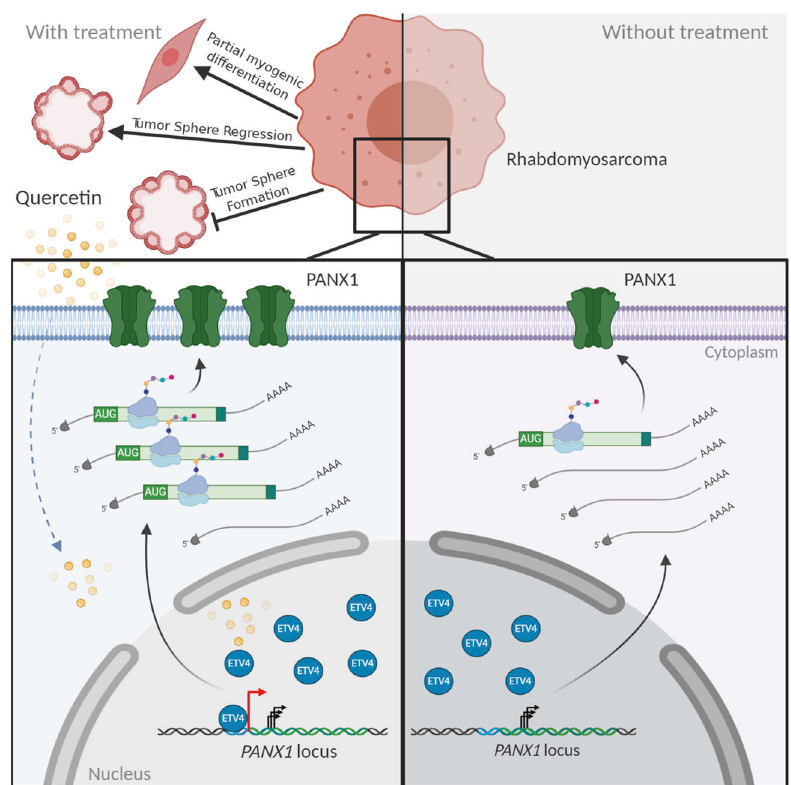
Fig. 8 Quercetin-induced transcriptional and translational control of PANX1 in RMS. Under normal culture conditions, the majority of basal PANX1 transcription starts after the ATG start codon generating truncated mRNA of varying lengths that are not readily translated into PANX1 protein. Quercetin treatment enhances the binding of ETV4 to its consensus site in PANX1 promoter, which allows the transcription of a variant of the PANX1 transcript containing a short (~43 bp) fragment of its putative 5 ′ UTR. This 5 ′ UTR-containing variant of the full-length